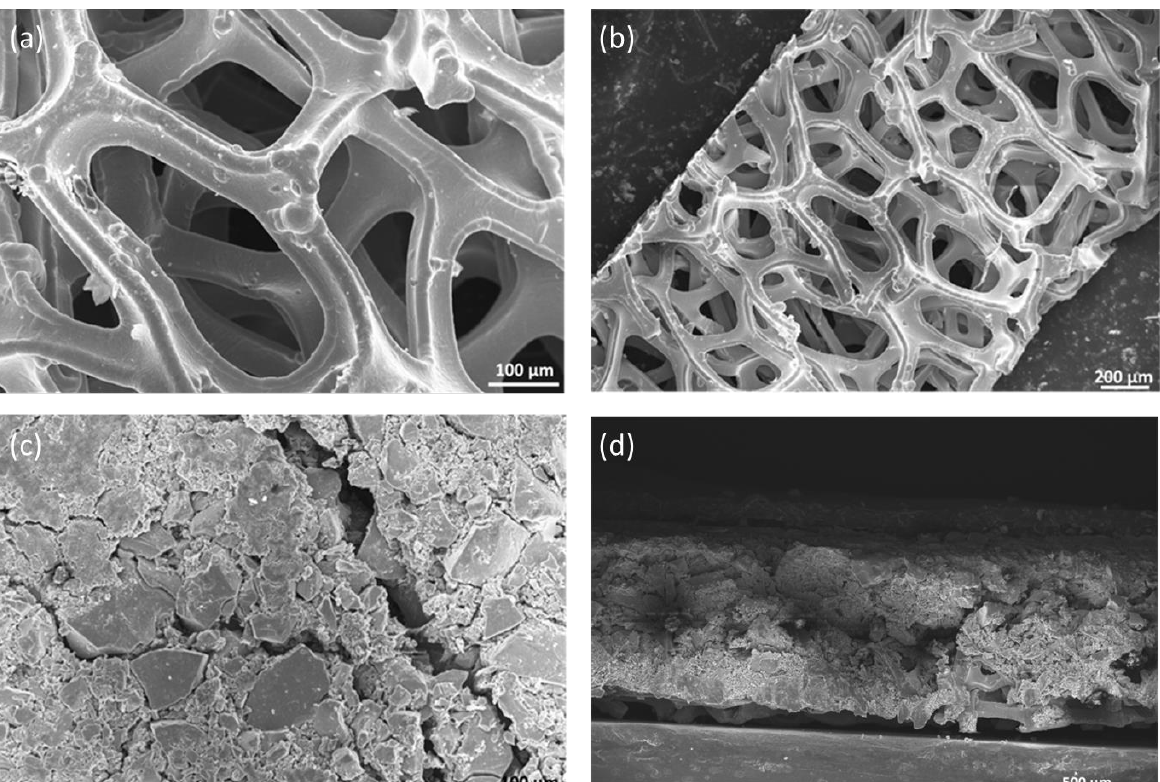
Figure 4. SEM images of ( a , b ) Nickel Foam without catalyst ( c ) NiFeCoO x coated on nickel foam and ( d ) Cross section image of nickel foam coated with NiFeCoO x catalyst.